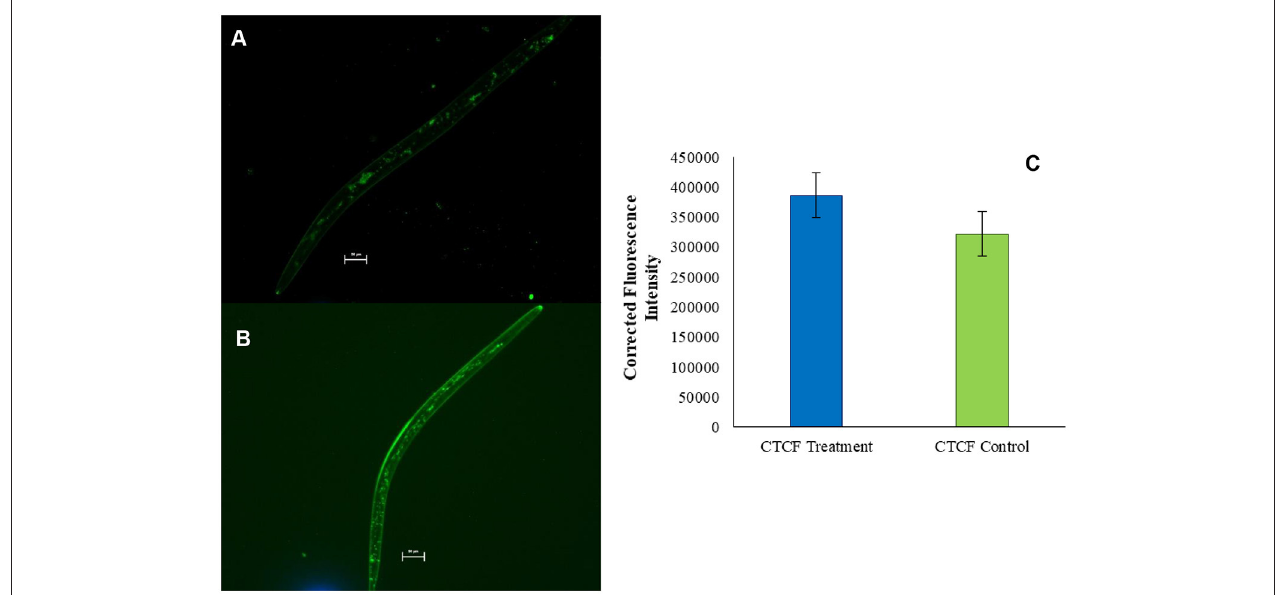
FIGURE 5 | Fluorescence microscopic images of M. incognita stained with Oil Red O (A) and Oil Red O mixed in MEO (B) ; comparison of the fluorescence intensities of the two samples (C) .